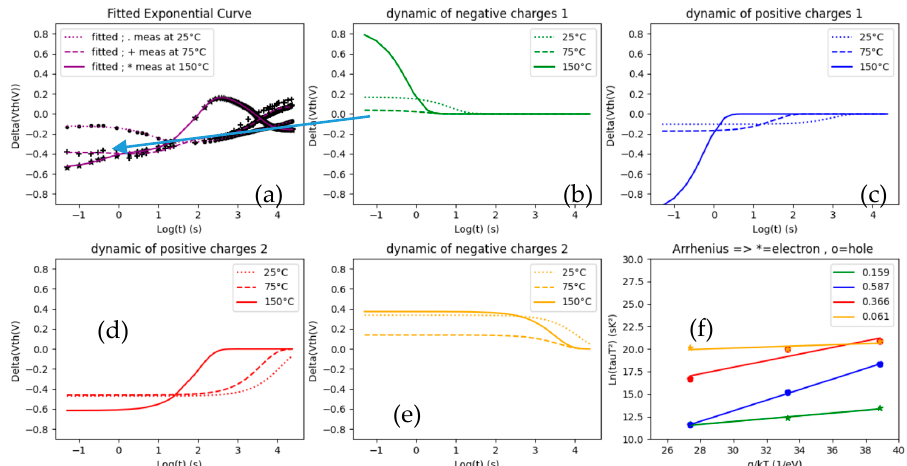
Figure 6. Design A wafer 1; ( a ) measurement at 25, 75 and 150 °C; ( b ) extraction of dynamic first level of negative charges; ( c ) extraction of dynamic first level of positive charges; ( d ) extraction of dynamic second level of negative charges; ( e ) extraction of dynamic second level of positive charges; ( f ) report of the four levels of charge in an Arrhenius graph (extraction of energy levels). Subfigures ( a – e ), show the Vth shift due to one trap level in function of time measured at 25, 75 and 150 °C. Subfigure ( f ), is the extraction of traps energies levels for each trap level.